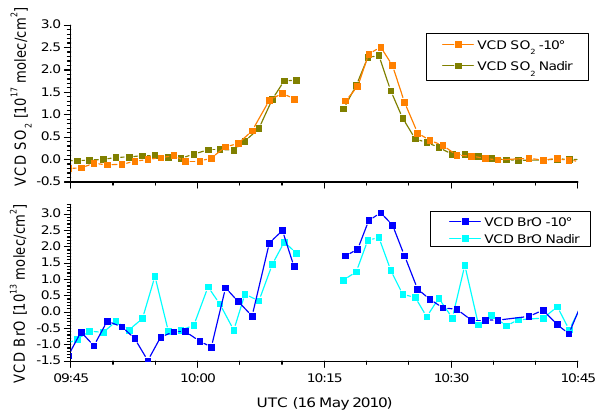
Fig. 13. Comparison of the vertical SO 2 columns, measured by CARIBIC (nadir) and GOME-2. For each CARIBIC DOAS mea- surement the pixels crossed by the aeroplane (forward and back- ward scans) are shown. Because the aeroplane made a u-turn just north of the plume, the GOME-2 pixels are the same before and af- ter the turn, resulting in the observed symmetry. During the turn the viewing geometry of CARIBIC changed very rapidly, and therefore no AMFs were calculated